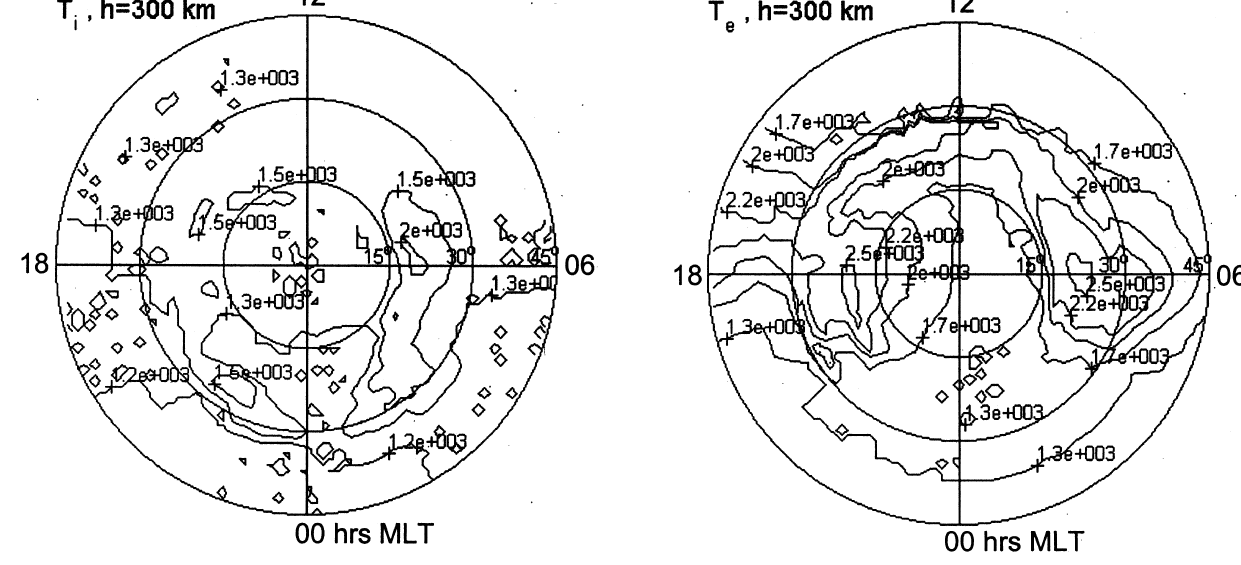
Fig. 10. Simulated distribution of the electron temperature (in K) at h = 300